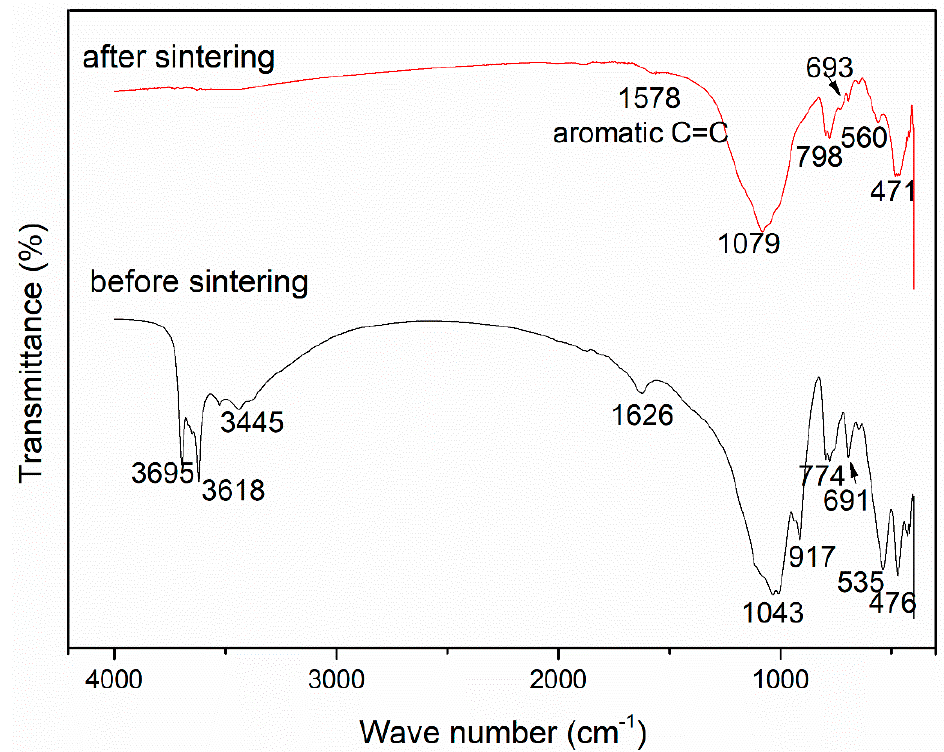
Figure 3. FTIR spectra of graphene bricks before and after sintering.